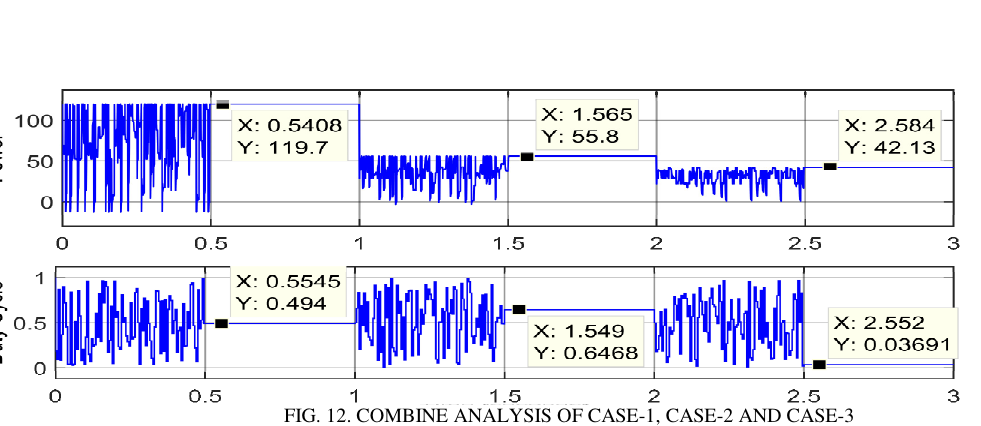
FIG. 12. COMBINE ANALYSIS OF CASE-1, CASE-2 AND CASE-3